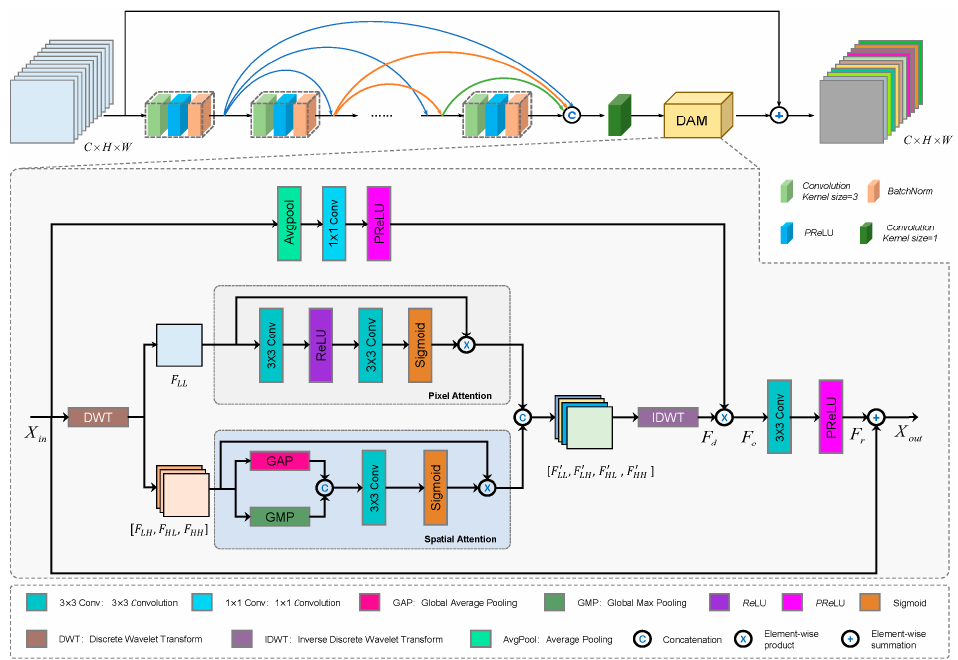
Figure 4. Illustration of the DARDM in the WDLB. Given an intermediate feature map X in ∈ R C × H × W , the DWT decomposes into half- resolution low-frequency sub-band ( F LL ) and high-frequency ( F LH , F HL , F HH )